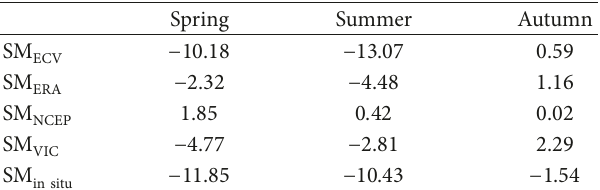
Table 4: The linear trends for seasonally averaged time series during 1988–2010 within the typical study region. They are expressed as the percentages (%) of soil moisture changes per decade (10a) with relevance to their long-term mean values.